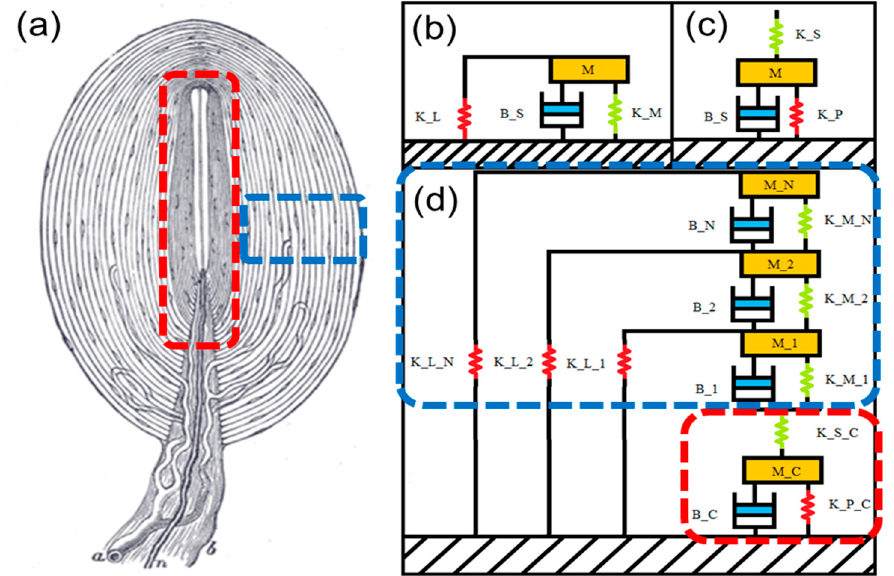
Figure 1. ( a ) Diagram of the PC structure, modified from [40]. ( b ) Mechanical model of a single layer, Kelvin–Voigt with a parallel spring and mass. ( c ) Mechanical model of the core, Kelvin–Voigt with a series spring and mass. ( d ) Mechanical model of an entire corpuscle.